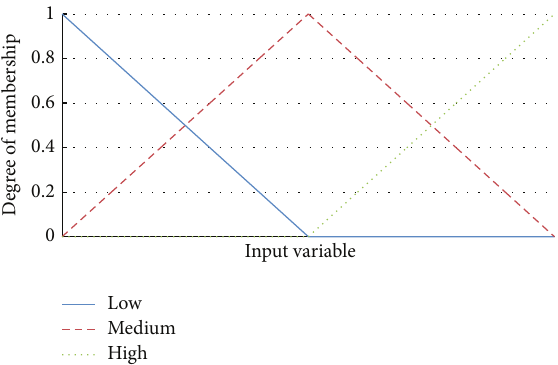
Figure 3: The fuzzy system scheme.